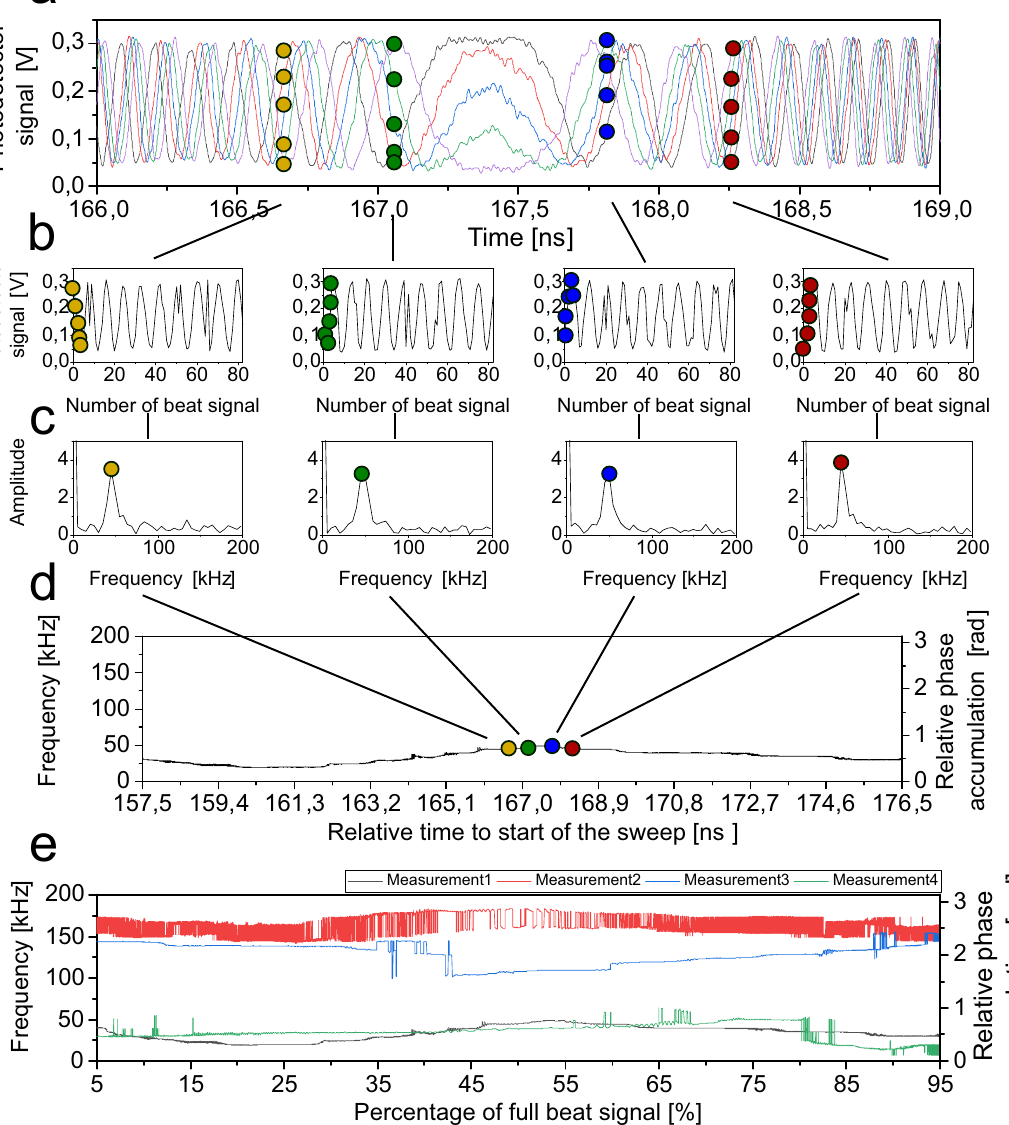
Fig. 4 All-Mode phase evolution experimental data. By analysing 83 consecutive sweeps, it is possible to analyse the phase evolution over all modes and many sweeps. We overlaid successive sweeps ( a ), generated single-mode phase evolutions ( b ) and calculated the fast Fourier transform (FFT)s ( c ) for each timepoint similar to the analysis in Fig. 3. Here, four exemplary modes are indicated by coloured circles. The phase evolution for all modes and all times is presented in ( d ) as a plot of the FFT frequency maximum over the time points. This plot reveals that the individual modes have a distinct and smooth phase relation between each other and over consecutive sweeps. Thus, we deduce that the Fourier domain mode-locked laser (FDML) laser output represents a well-de fi ned wavelength sweep with a continuously chirped phase light fi eld both along a sweep (i.e. from mode-to-mode) and over multiple sweeps (i.e. from sweep-to-sweep). e We repeated this measurement several times and found that the phase always has a connected and locally smooth shape apart from a step-like resolution artefact which is sometimes visible and is likely caused by the limited frequency resolution due to the fi nite record length of the measurement (see Supplementary Note 4 for discussion). We also found that the averaged frequency value drastically changes from measurement to measurement even if all parameters were the same. That is due to continuous wave (CW) laser mode hops in between measurements. Slight changes within the frequency evolution could be traced back to changes in the FDML light fi eld. Larger changes between different measurements could be traced back to small alterations of the CW ring laser